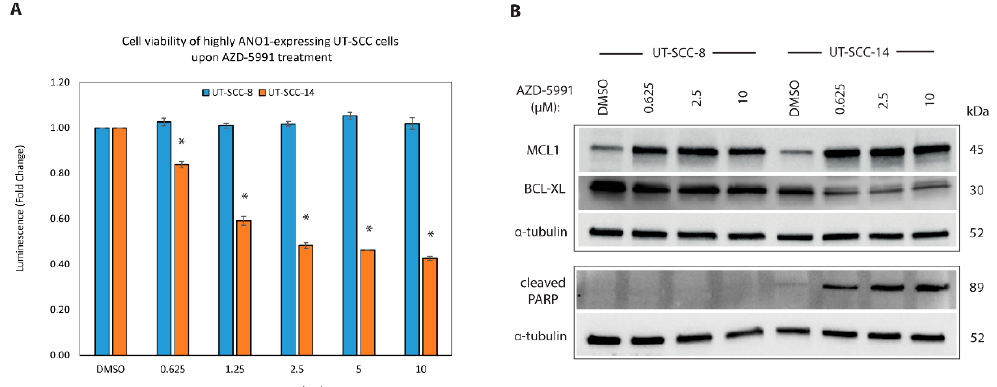
Figure 6. Targeted inhibition of MCL1 decreases cell viability and induces apoptosis in the selected ANO1 HIGH cell line. ( A ) Bar plot illustrating the efficacy of BH3-mimetic AZD-5991, as measured by cell viability (Cell Titer Glow ® ) in ANO1 HIGH cell lines, * p -value < 0.05. ( B ) Western blot panels showing the protein levels of MCL1, BCL-XL, and cleaved-PARP in UT-SCC-8 and UT-SCC-14, upon treatment with the indicated concentrations of AZD-5991.